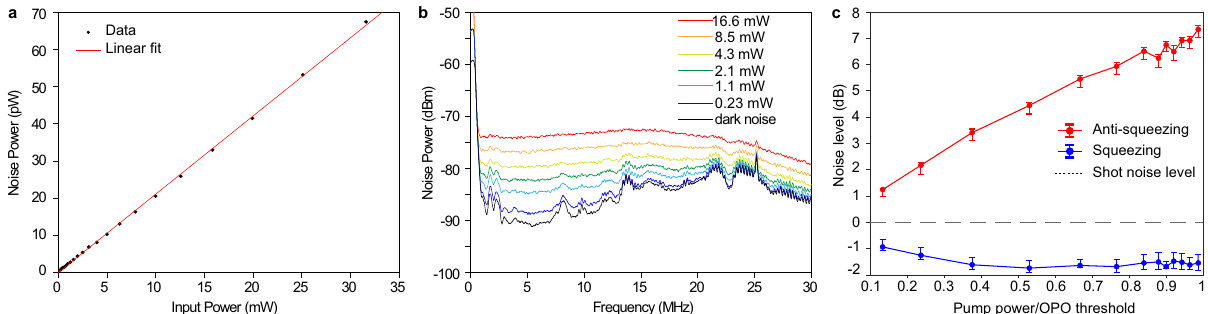
Fig. 6 Characterization of the balanced photodiodes, and squeezing dependence on optical pump power. a Noise power vs. the optical power of local oscillators sent into the PDs. The noise power is measured at 2.7 MHz frequency, and the dark noise from the PDs has been subtracted from the noise power. The linear trend indicates the balanced photodiodes are operated in the shot noise-limited regime. b Electrical spectra of the balanced PD outputs at different local oscillator powers. All measurements in this fi gure are taken at 100 kHz resolution bandwidth. c Measurement of squeezing and anti- squeezing versus pump power for qumode ( − 4, 4). The error bars are concluded with a 95% con fi dence interval